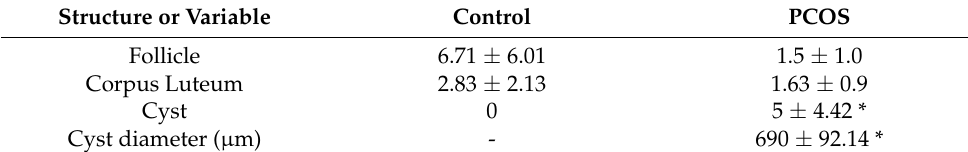
Table 3. Number of follicles, corpus lutea, and cysts in the Control and PCOS groups. Structure or Variable